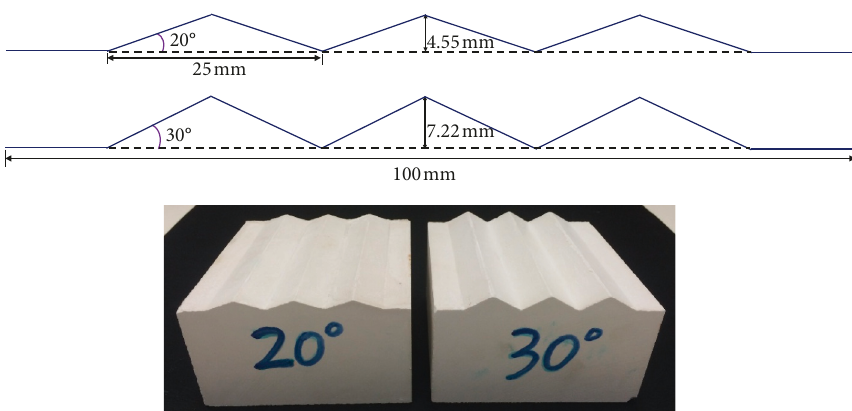
Figure 5: Profile geometry of rock fracture replicas and experimental samples (after Li et al.